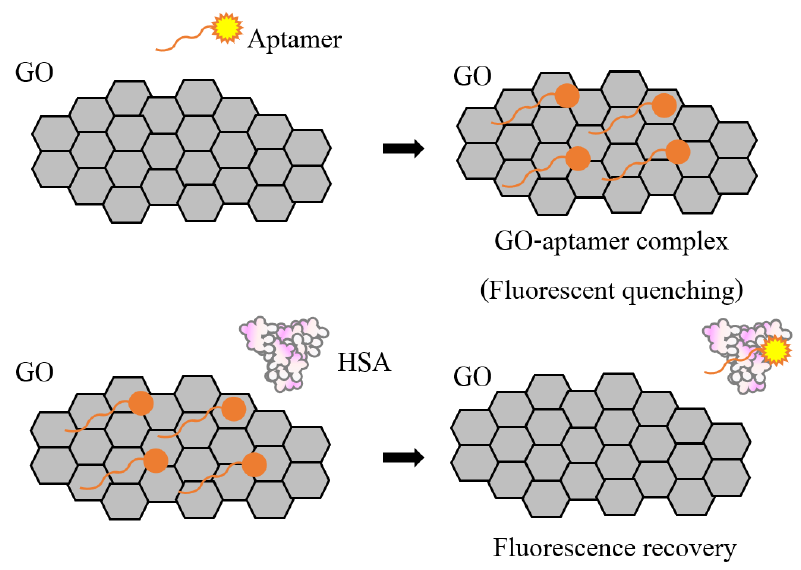
Figure 1. Schematic showing aptasensor technology for albumin detection used in this study. The simulation results indicated that the aptamer binding sites on the HSA protein were in subdomain IIIB [17]. Molecular dynamic simulation also revealed that the polar and charged amino acid residues play an important role in maintaining the affinity binding of the aptamer to lysine (K), arginine (R), histidine (H), glutamic (E), and aspartic (D) amino acid residues [17]. Therefore, the aim of this study was firstly to explore the efficiency of graphene oxide-based fluorescent detection for detecting urinary albumin that has been stabilized in boric acid-preserved urine under different storage conditions and tempera- tures, and secondly, to compare the efficiency of the developed method with the standard methods of detection used in